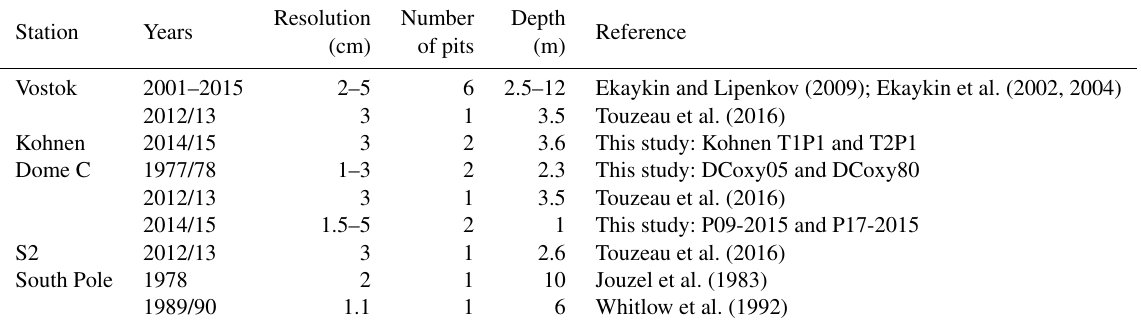
Table 3. Summary of the different snow pits, the respective sampling depths and vertical resolution. Station